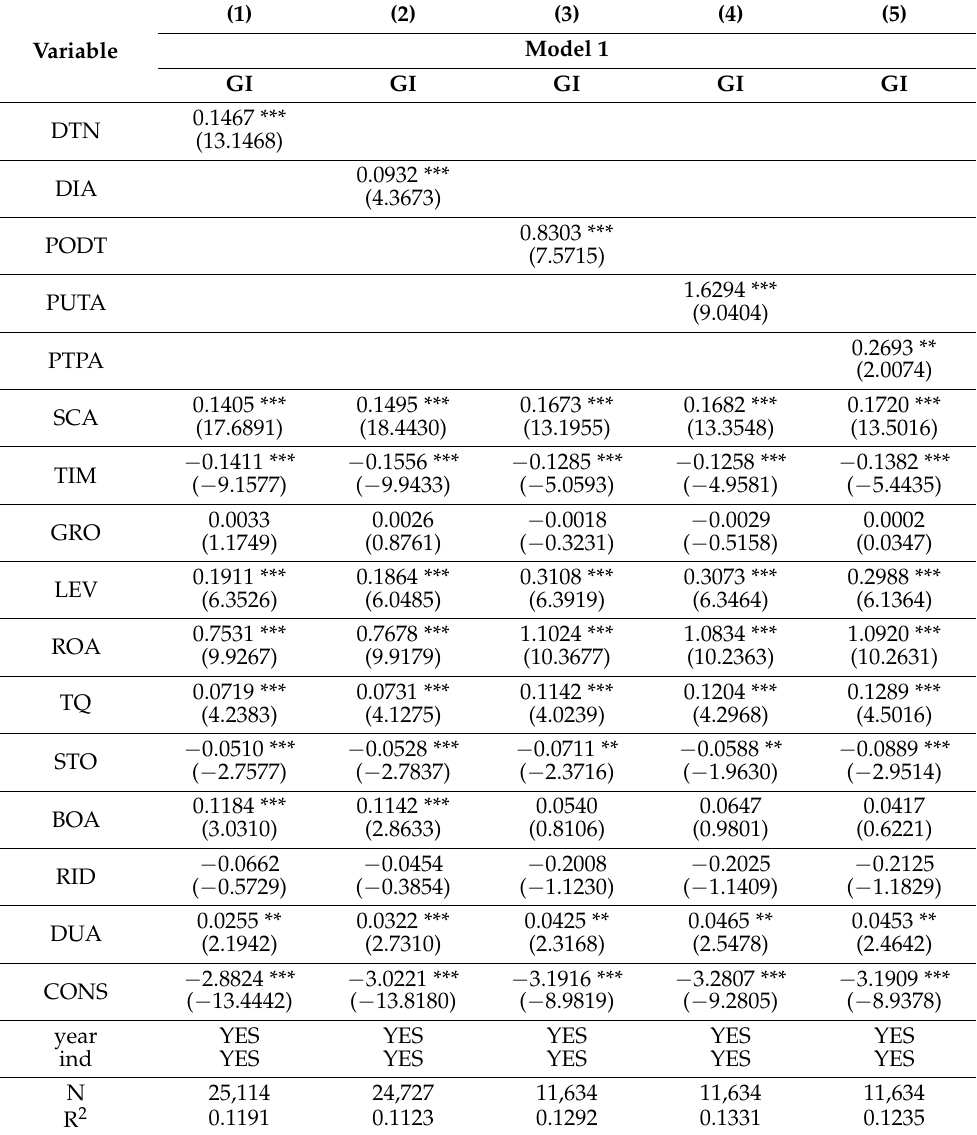
Table 12. Robustness test results